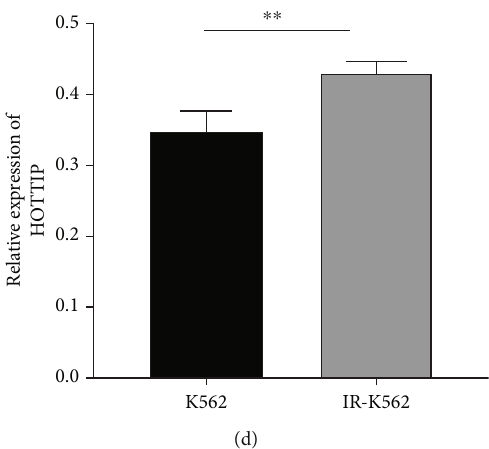
Figure 1: HOTTIP is highly expressed in CML. (a) RT-qPCR was used to detect. Note: HOTTIP level in BM-MNCs of CML patients and BM-MNCs of healthy donors. Normalized to GAPDH. ∗∗∗ p < 0 : 001 vs. NC. (b) K562 and IR-K562 cells were treated Imatinib in di ff erent concentrations for 48h. Imatinib IC50 was evaluated by CCK-8 assay. ∗∗∗ p < 0 : 001 . (c) Cell apoptosis rate was detected by fl ow cytometry using Annexin V-APC/PI staining. The right panel shows the apoptosis rate from three independent experiments. ∗∗ p < 0 : 01 vs. sh-con. (d) RT-qPCR was used to detect HOTTIP levels in CML cell lines (K562 and